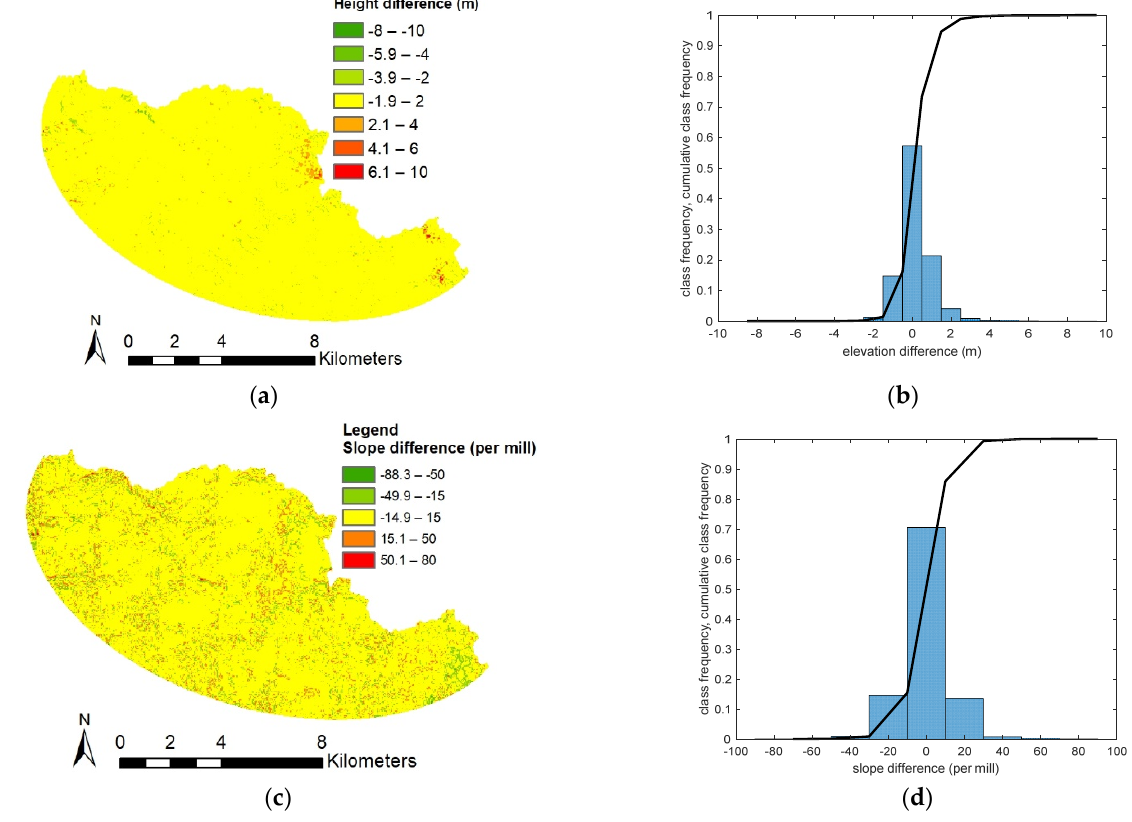
Figure 6. Differences between ALOS PALSAR and SRTM 90 DEM in the study site. ( a ) Map of the elevation difference. ( b ) Frequency distributions of the elevation difference. ( c ) Map of the slope difference. ( d ) Frequency distributions of the slope difference.